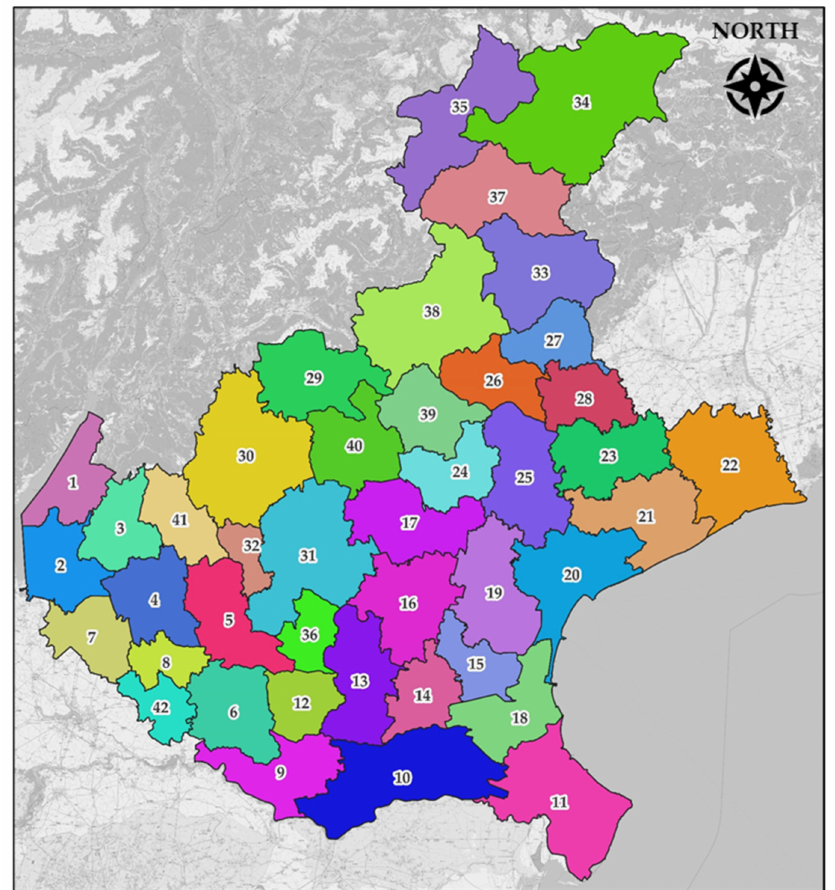
Figure 4. Veneto region: study area and